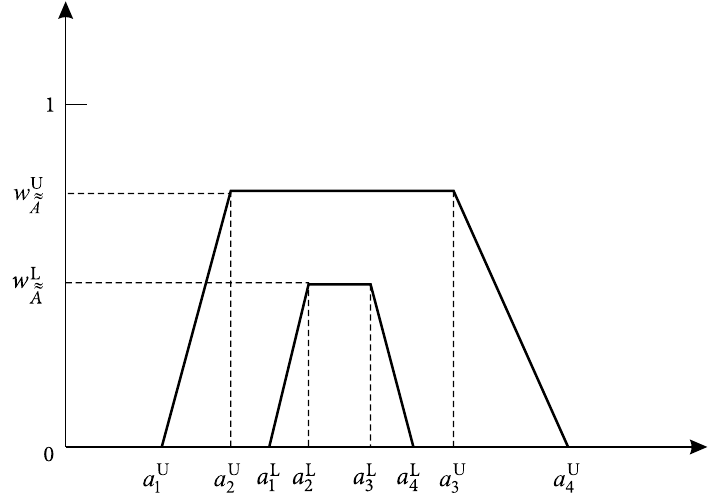
Fig. 1. An interval-valued trapezoidal fuzzy